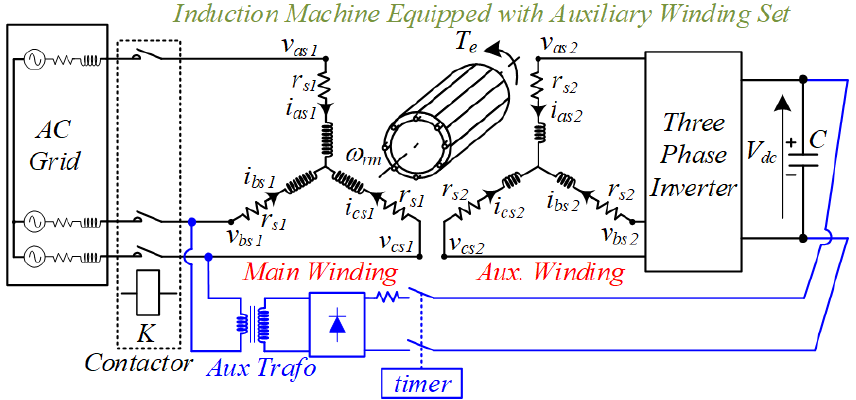
Figure 17. Floating capacitor low-power, low-voltage charging circuit.